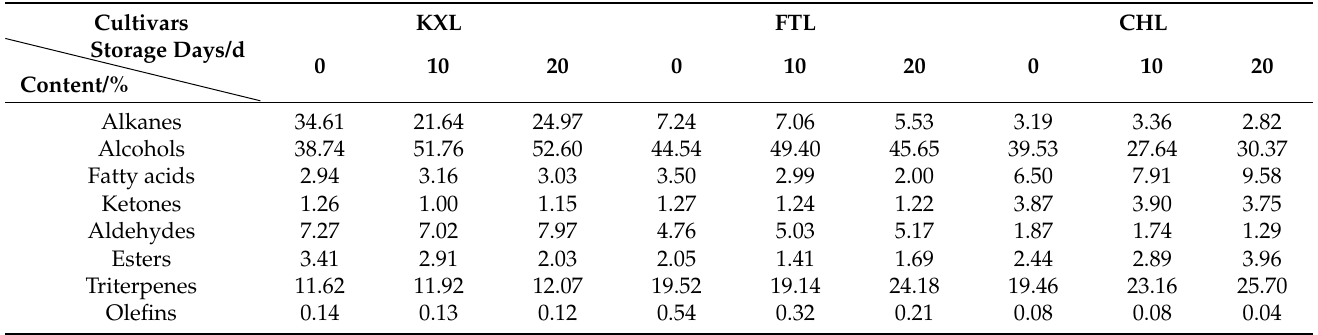
Table 1. Changes in proportion of cuticular wax composition among three plum cultivars during storage at room